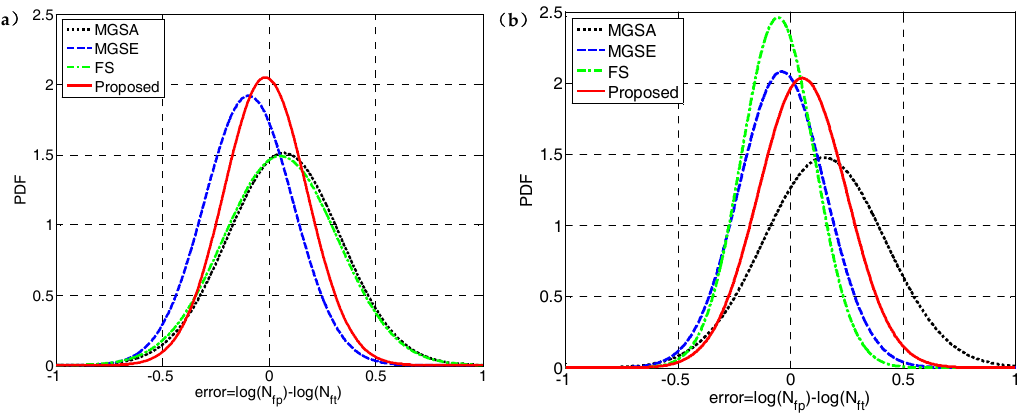
Figure 8. Probability density functions of model prediction errors for: ( a ) TC4 under symmetric loadings; and, ( b ) GH4169 at 650 ° C.